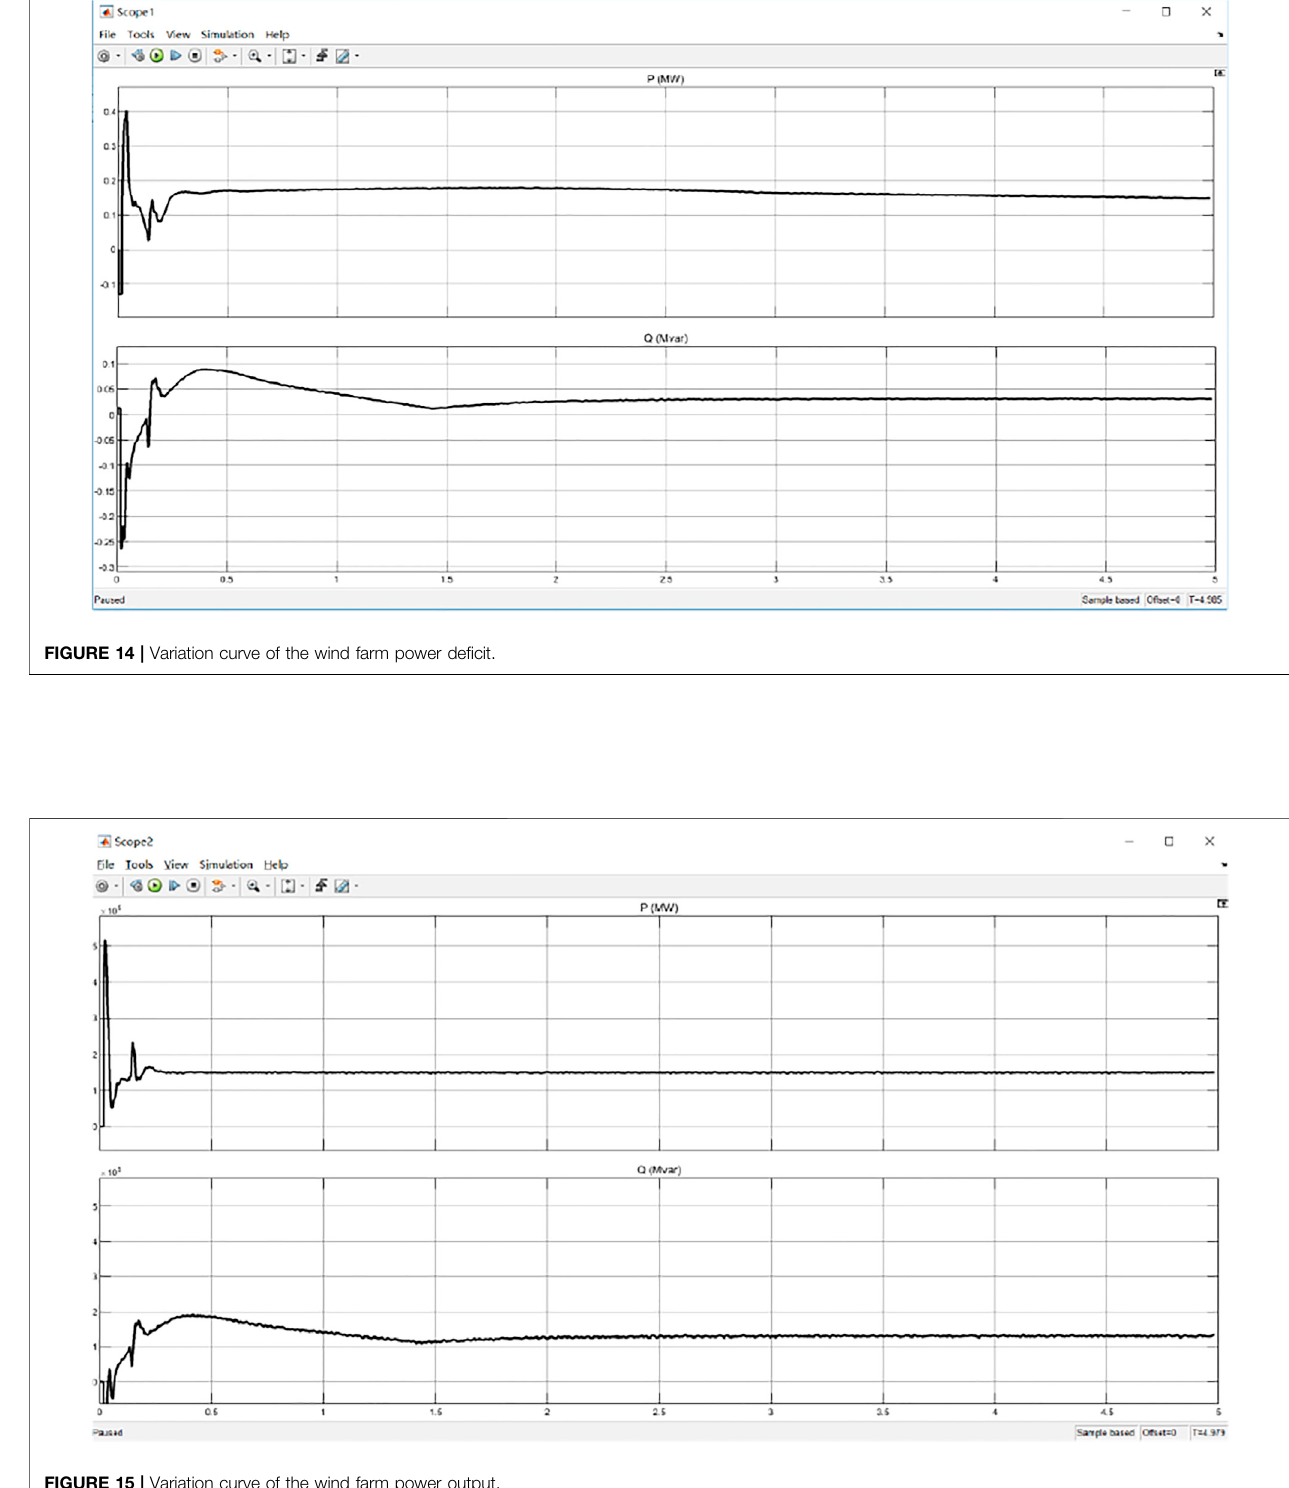
Frontiers in Energy Research |